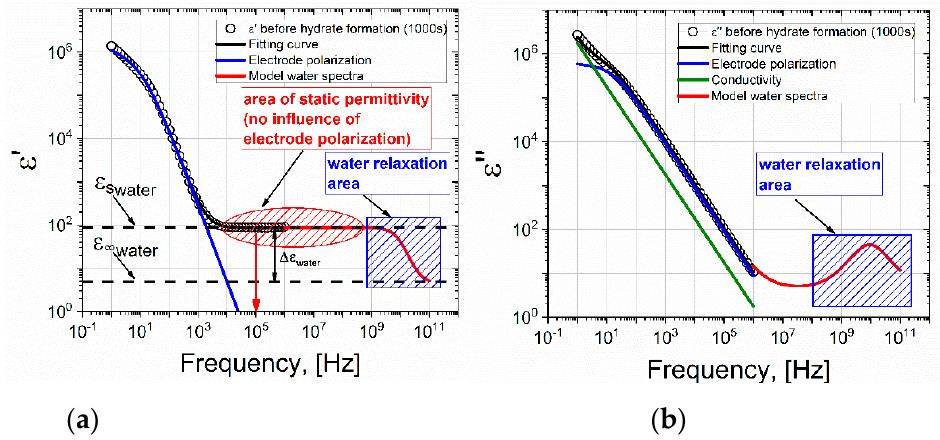
Figure 5. ( a ) Real and ( b ) imaginary parts of the dielectric spectrum of the water-gas system at the time t = 2000 s, before the formation of the hydrate (273 K, 9 MPa). The black line represents the fitting function constructed in accordance with equation (2); the blue line represents the contribution of electrode polarization; the green line is DC conductivity; and the red line is the model spectrum of water.